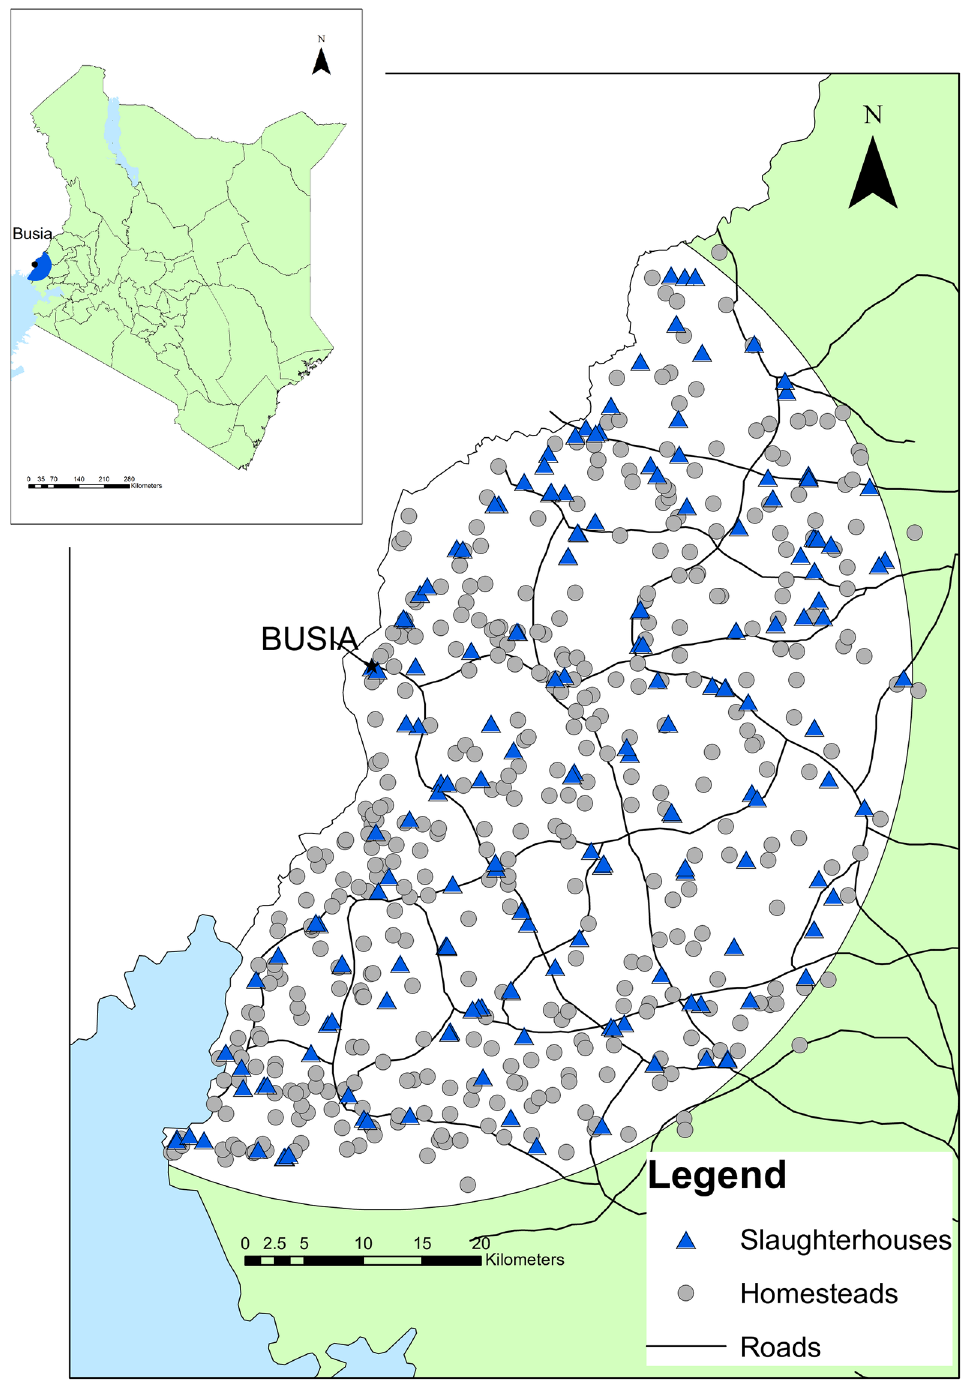
Fig 1. Map of the study area, indicating the distribution homesteads and slaughterhouses.